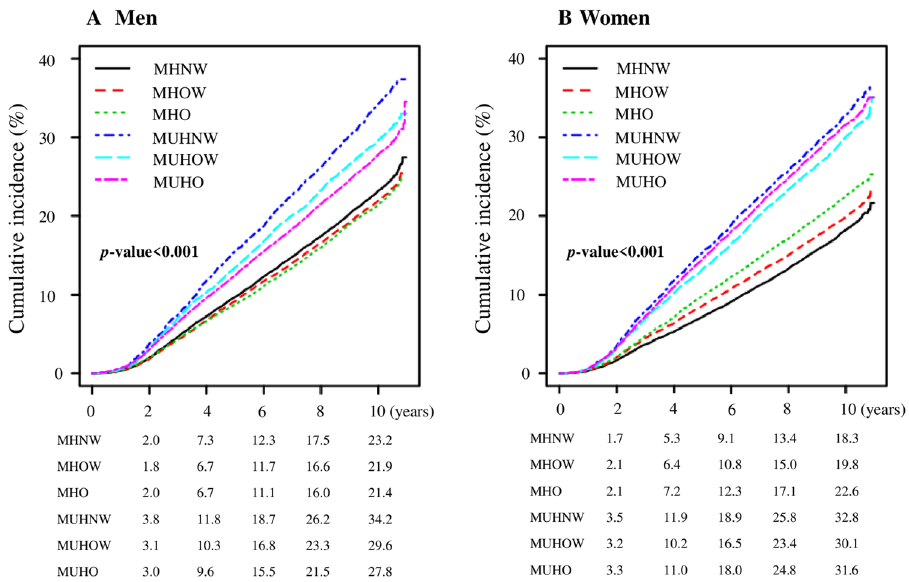
Figure 2. Cumulative incidents of composite outcome (all-cause mortality and incidence of cardiovascular diseases) according to metabolic healthy and